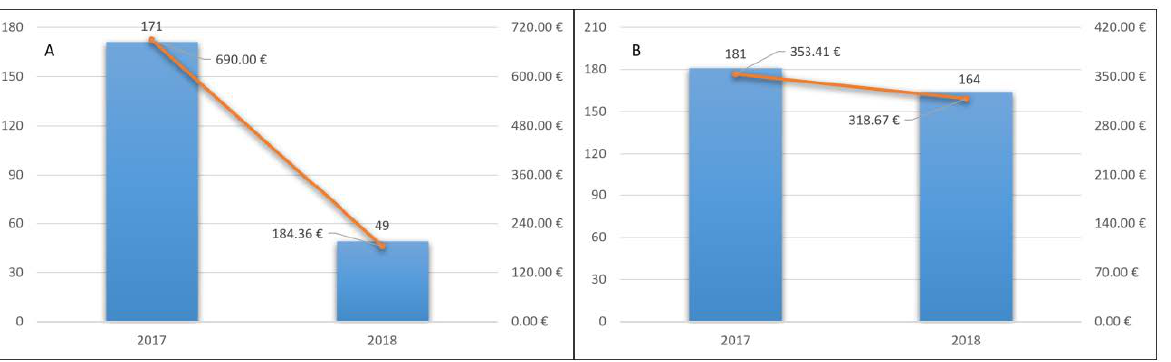
Figure 2. Naïve patients treated with NOACs ( A ) and with VKA ( B ) and related pharmaceutical spending. Of these patients, 171 (11.3%) were hospitalized in 2017 and the total number of hospitalizations was 235. The total cost of hospitalizations was 1,041,216.54 euros. The average cost for inpatient was 6088.99 euros. The average cost for a patient treated with NOACs was 690 euros (Figure 3A).